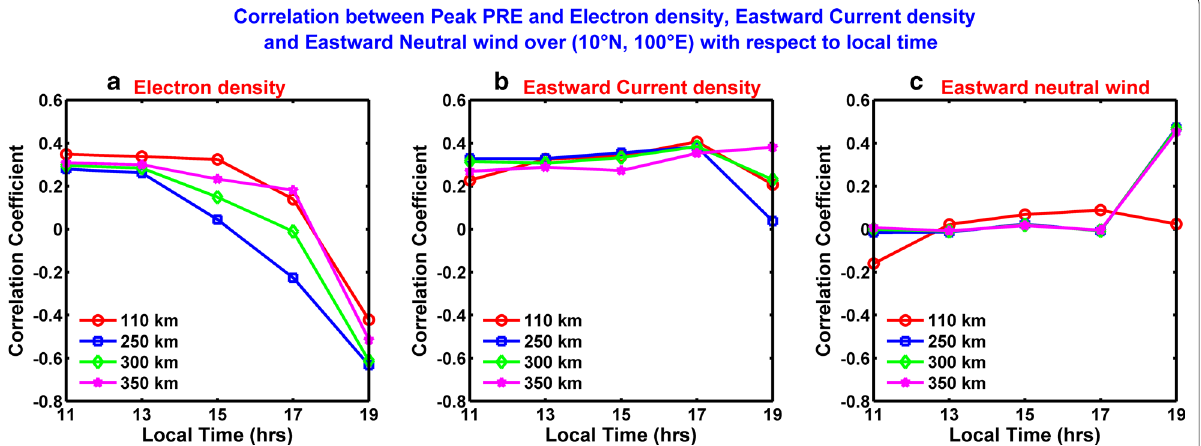
Fig. 5 Correlation coefficients of the day-to-day variation of the peak PRE with a electron density, b eastward current density, and c eastward neutral wind at different local time at the altitudes of 110 km (red line), 250 km (blue line), 300 km (green line) and 350 km (magenta line) over (10° N, 100° E; GAIA co-ordinates) near Chumphon in